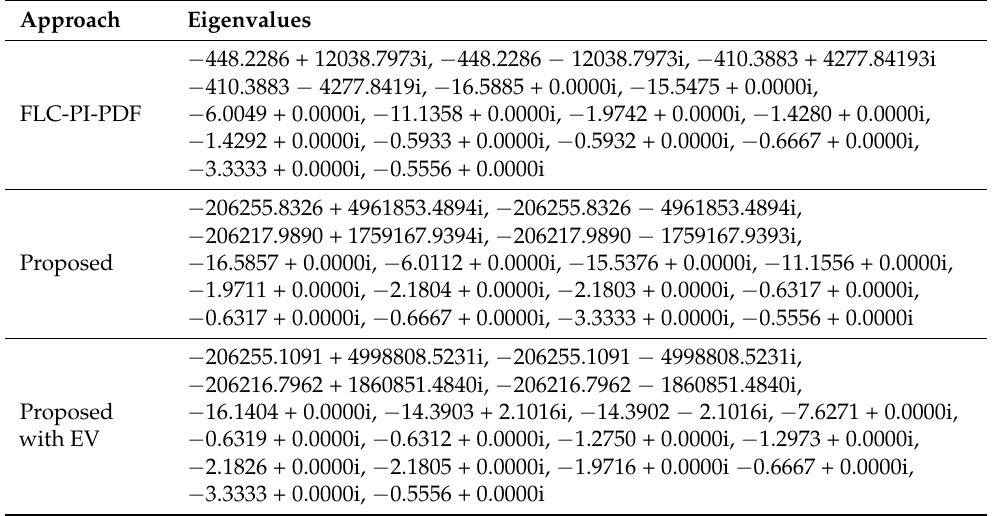
Table 5. Eigenvalues for different control